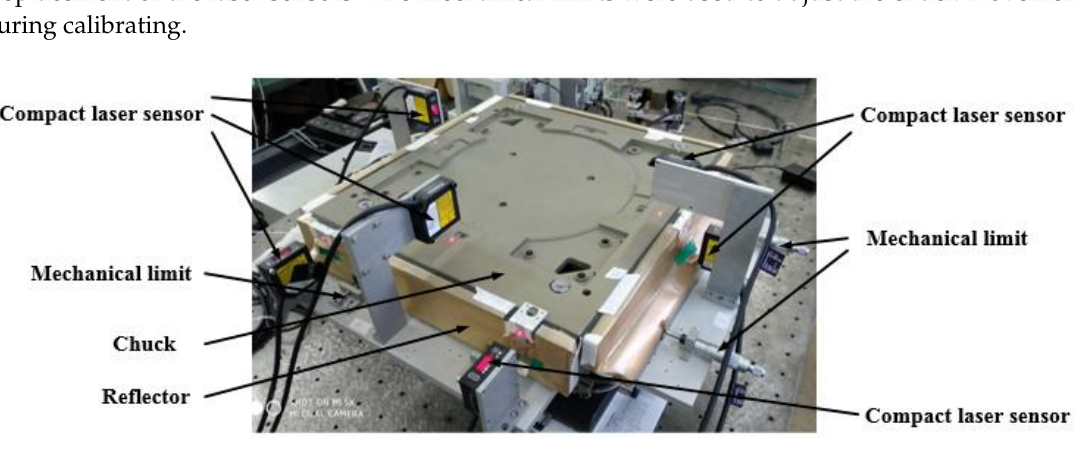
Figure 7. The laser sensors output displacement (blue) and the Hall sensors output voltage (red) sampled by the host computer.